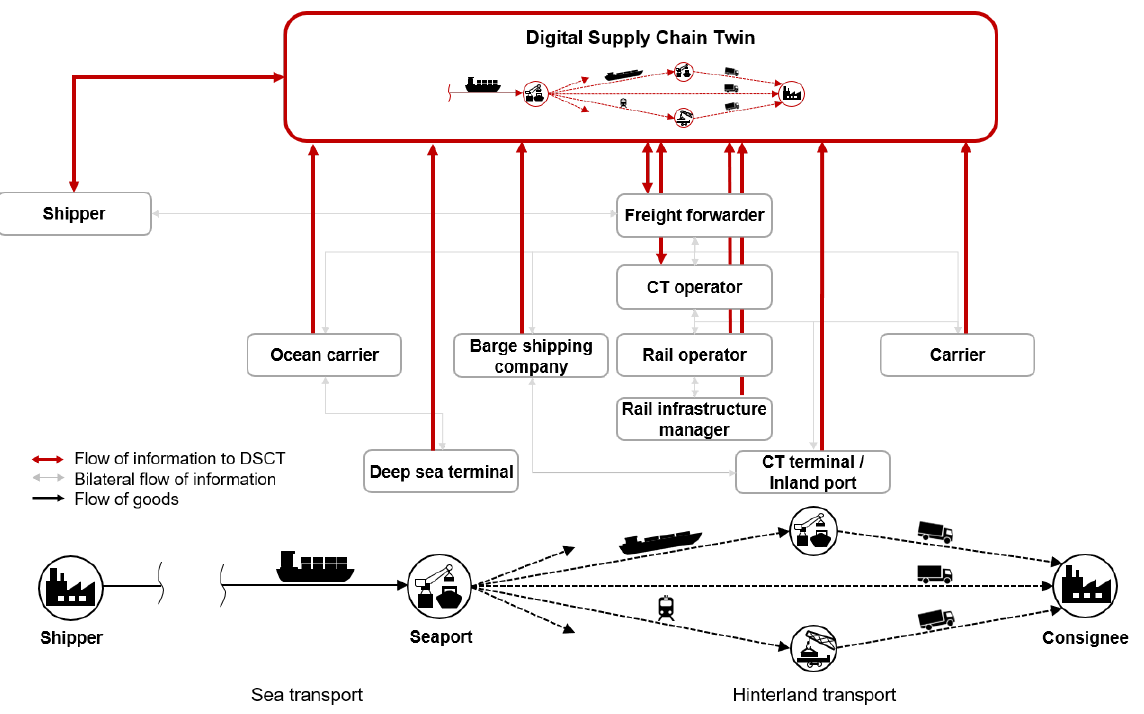
Figure 4. Exemplary flow of goods and information within a maritime transport chain with an additional